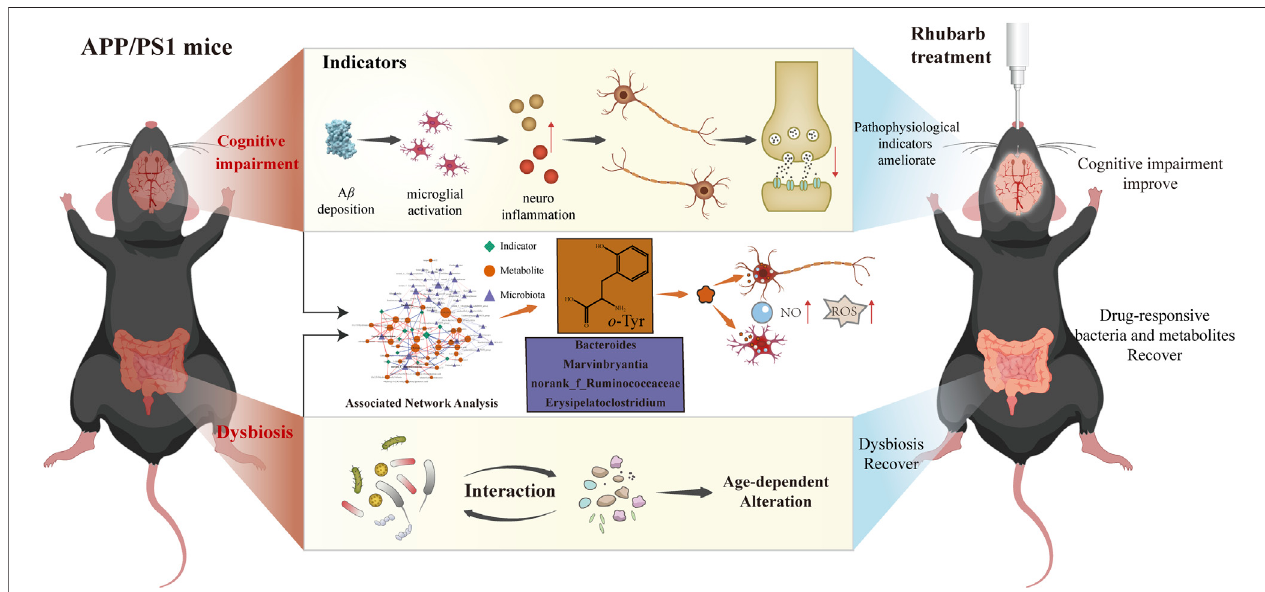
FIGURE 9 | Rhubarb alleviates cognitive impairment in APP/PS1 mice by regulating drug-responsive bacteria and their corresponding microbial metabolites.